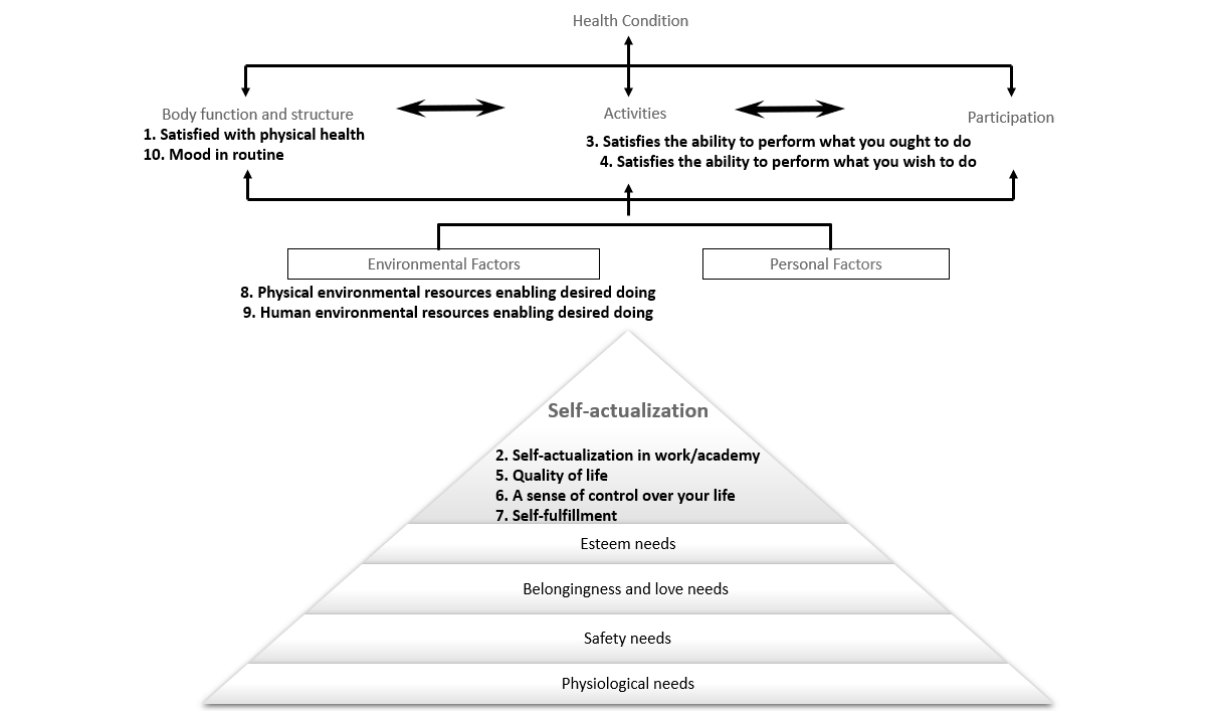
Figure 1. The 10 items of the Daily Functional Actualization questionnaire, derived from both the International Classification of Functioning, Disability, and Health [19] and Maslow’s theoretical concepts